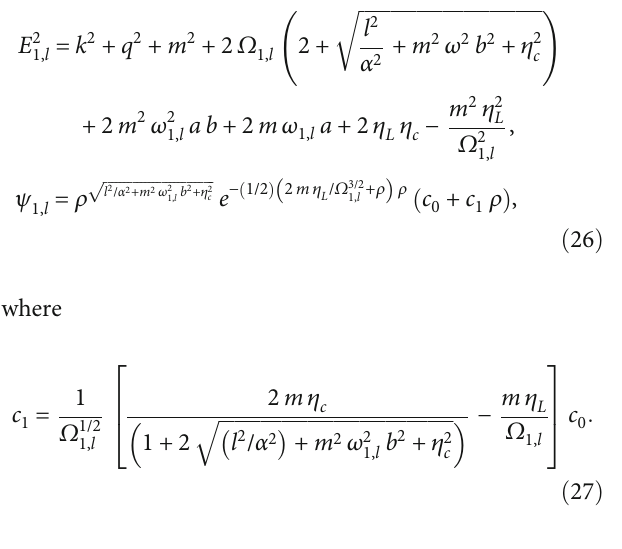
Figure 5: n = l = k = q = a = b = η